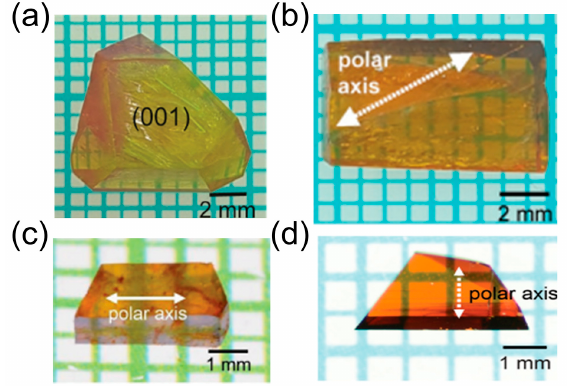
Figure 17. Crystal photos of ( a ) OHP-CBS [63]; ( b ) OHQ-CBS [44]; ( c ) HMQ-4TFS [29]; and ( d ) HM6FQ-T